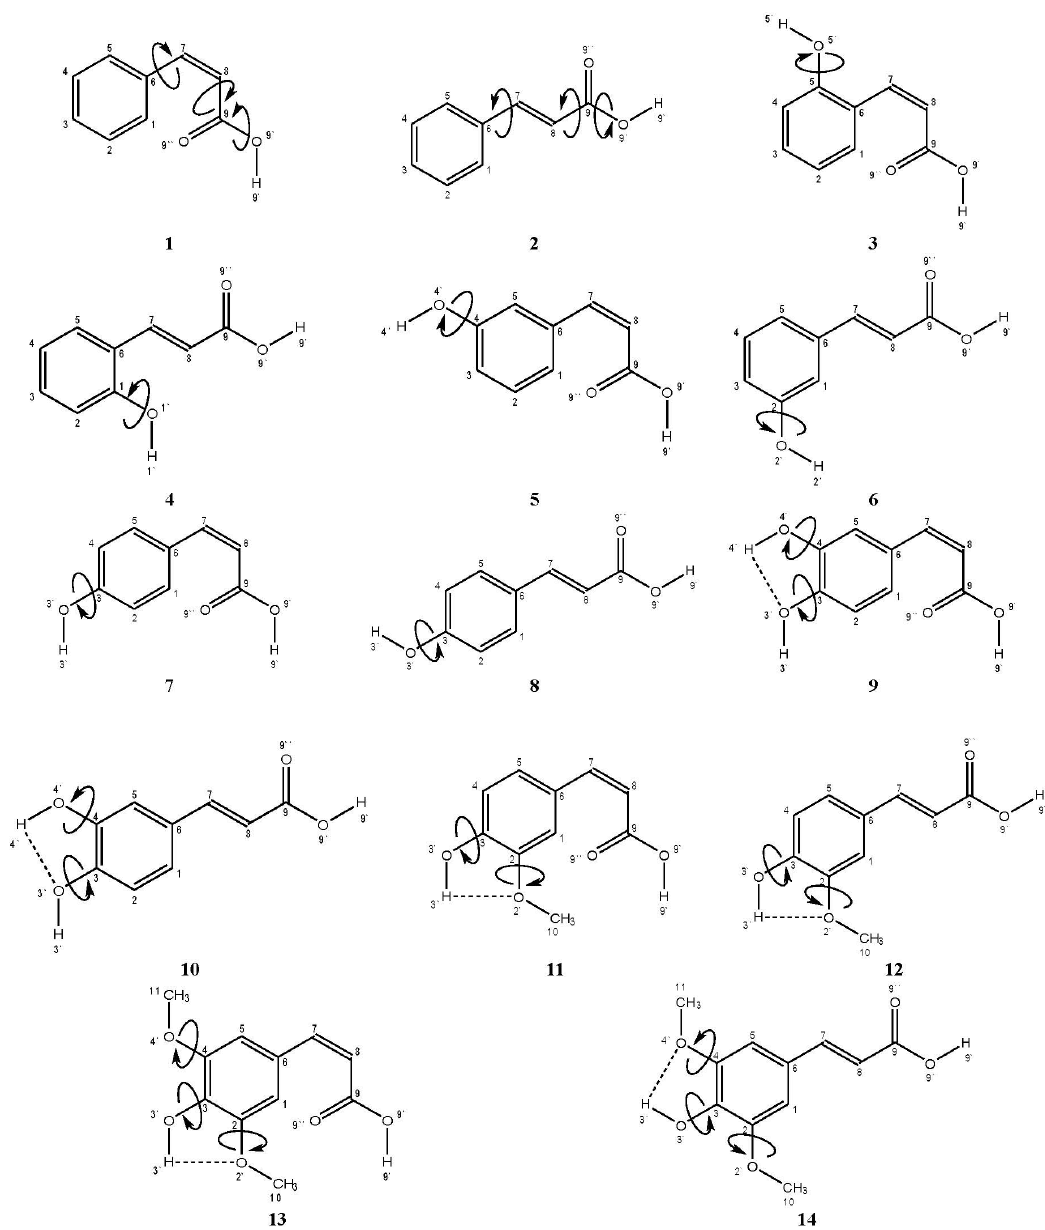
Figure 1: Schematic representation of the most stable calculated conformers of (1) cis -cinnamic acid, (2) trans -cinnamic acid, and related derivatives: (3) cis - o -coumaric acid, (4) trans - o -coumaric acid, (5) cis - m -coumaric acid, (6) trans - m -coumaric acid, (7) cis - p -coumaric acid, (8) trans - p -coumaric acid, (9) cis -caffeic acid, (10) trans -caffeic acid, (11) cis -ferulic acid, (12) trans -ferulic acid, (13) cis -sinapinic acid and (14) trans -sinapinic acid. The atom numbering and internal hydrogen bonds are also